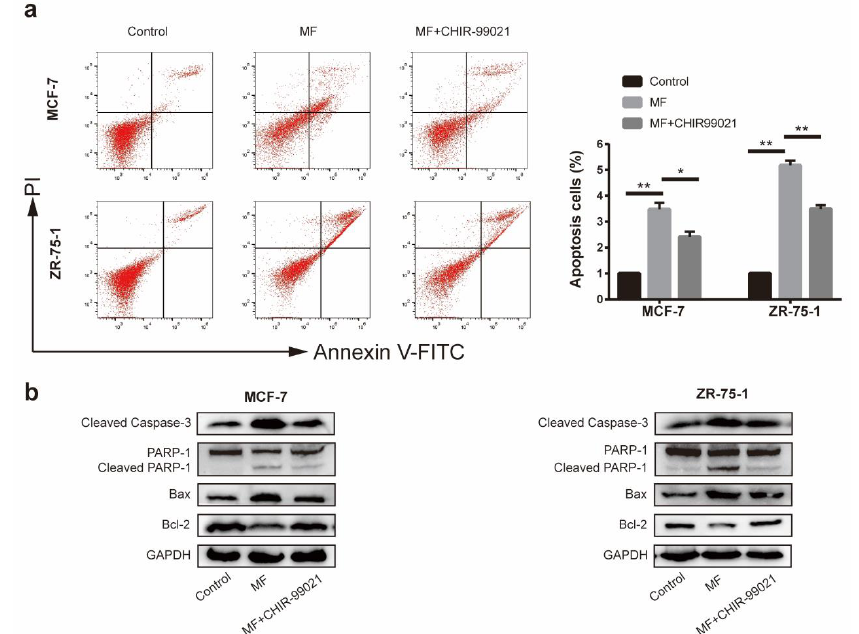
Figure 7. LF-MF induced MCF-7 and ZR75-1 cells apoptosis by activating GSK-3β. ( a ) (left) Flow cytometry analysis with Annexin V/PI staining showing that inactivating GSK-3β rescued MF-induced apoptosis. (right) Histograms show the mean percentage of cells with apoptosis. ( b ) Western blotting was performed to analyze the expressions of cleaved caspase-3, PARP1, Bax, and Bcl-2 in MCF-7 and ZR-75-1 cells after MF treatment and / or CHIR-99021. Data are presented as the mean ± standard deviation (SD); n = 3; * p < 0.05, ** p <